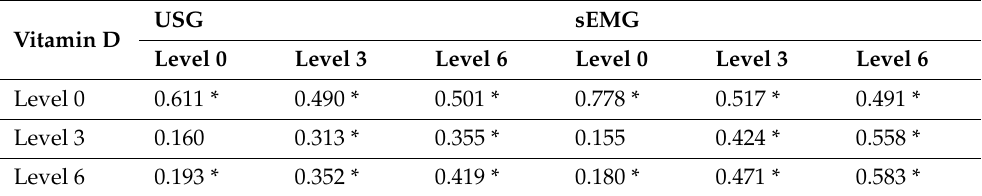
Table 2. Correlation coefficients between Vitamin D and USG; Vitamin D and sEMG. Vitamin